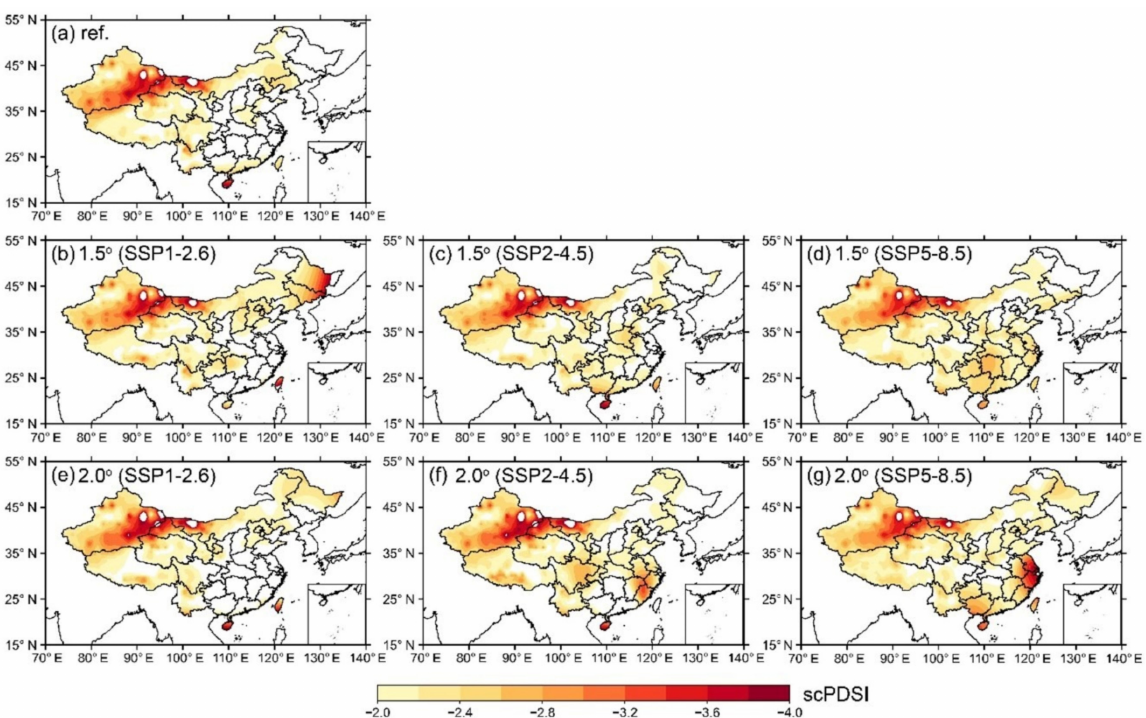
Figure 4. Spatial patterns of drought severity during ( a ) the reference period (1995–2014), ( b – d ) the 1.5 ◦ C global warming period, and ( e – g ) the 2.0 ◦ C global warming